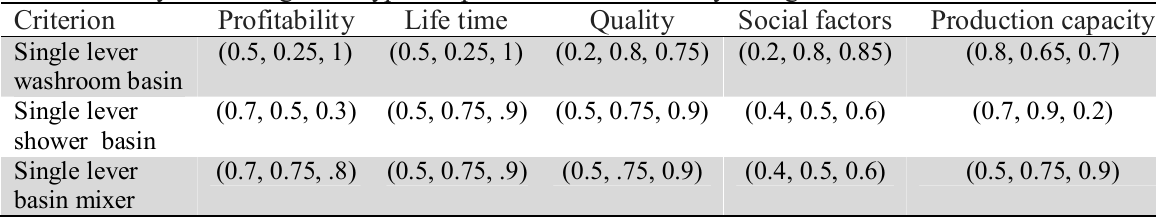
The summary of ranking three types of products in terms fuzzy triangular numbers